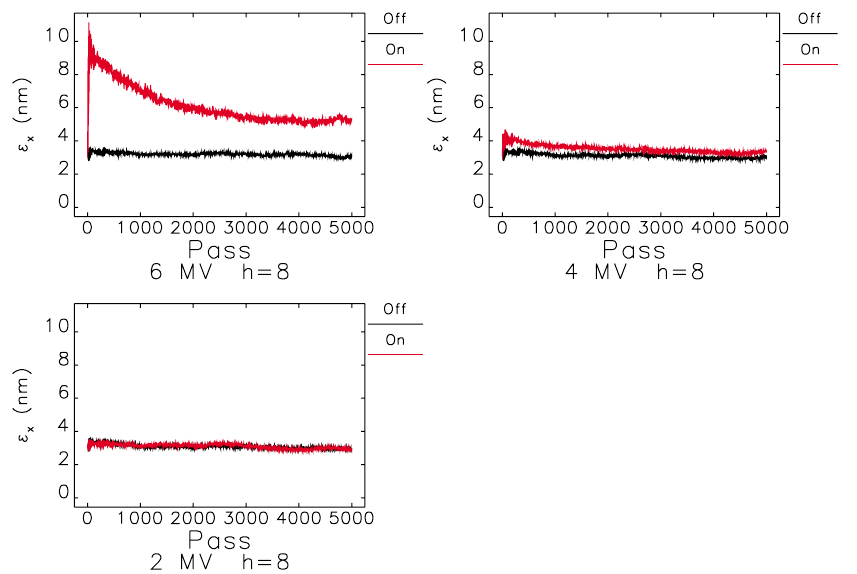
FIG. 12. (Color) Horizontal emittance vs pass including synchrotron radiation effects, with interior sextupoles on and off.